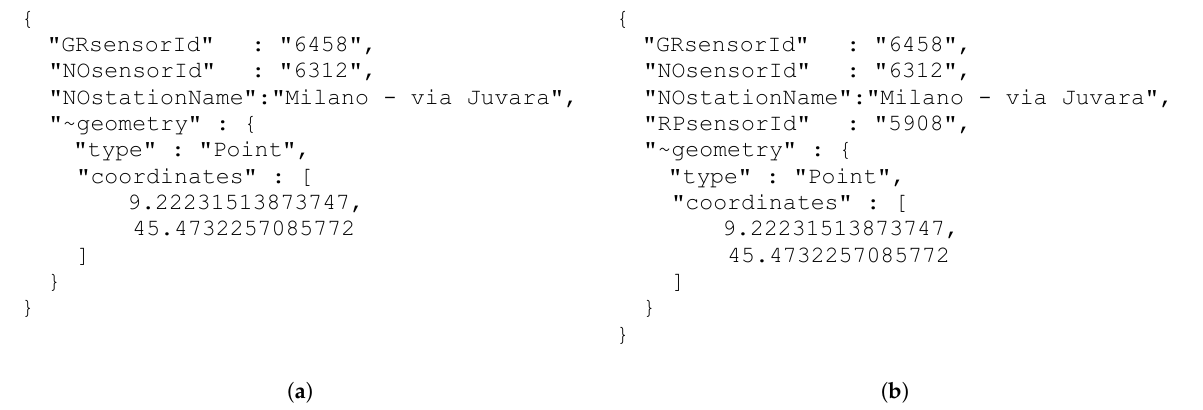
Figure 8. Examples of documents in the collections generated by line 12 ( a ) and by line 14 ( b ). ( a ) Example of documents in the SensorPairs collection. ( b ) Example of documents in the SensorTriplets